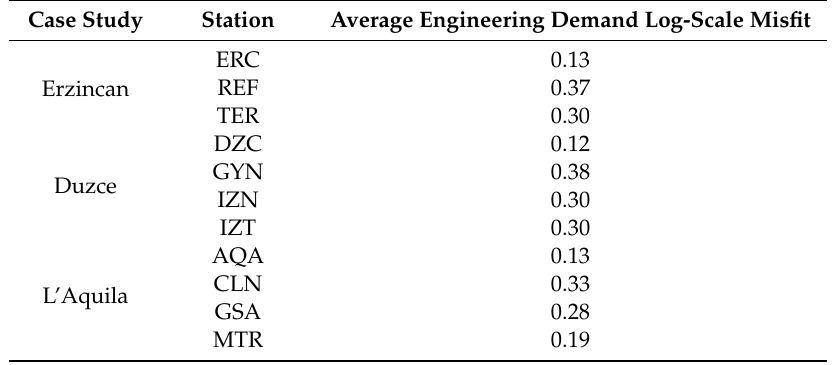
Table 6. Average engineering demand log-scale misfits at all stations for all case